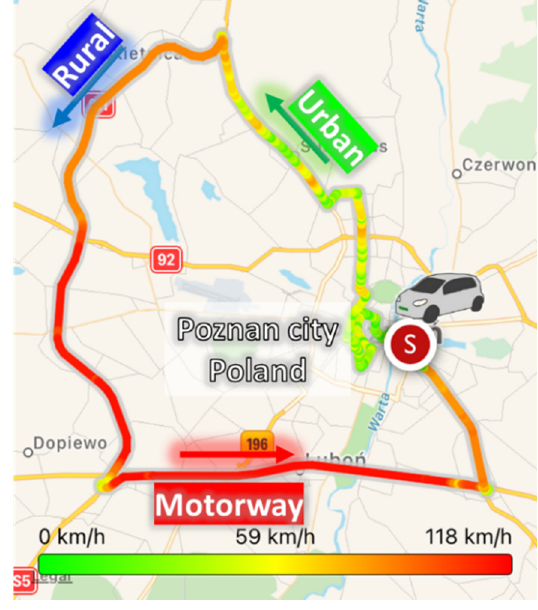
Figure 11. Route pattern followed in the research.